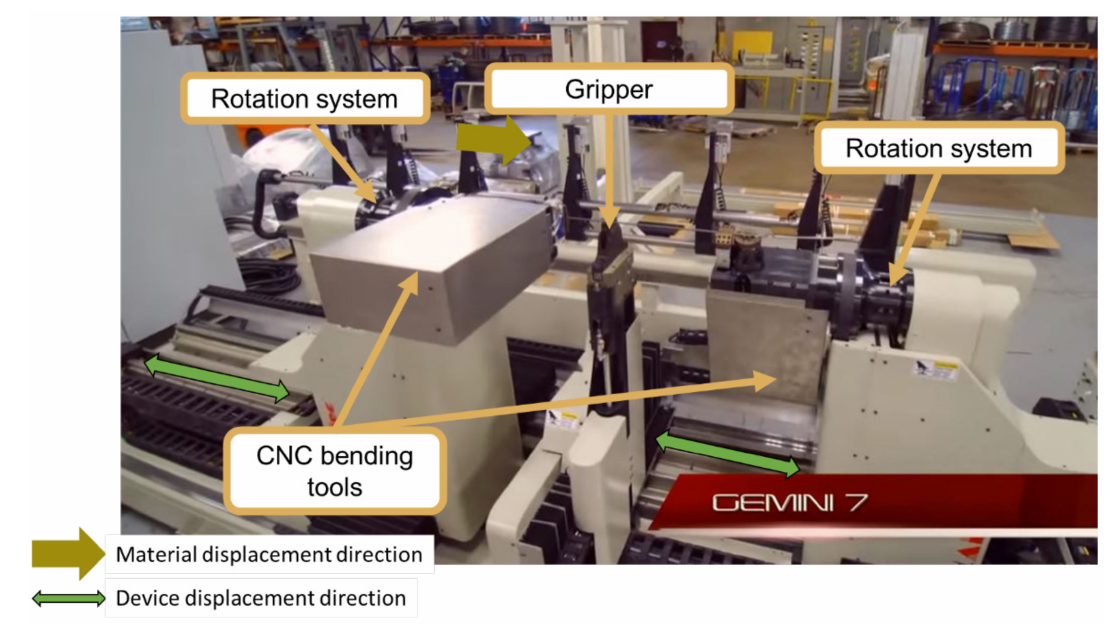
Figure 12. Wire-bending equipment Gemini 7.